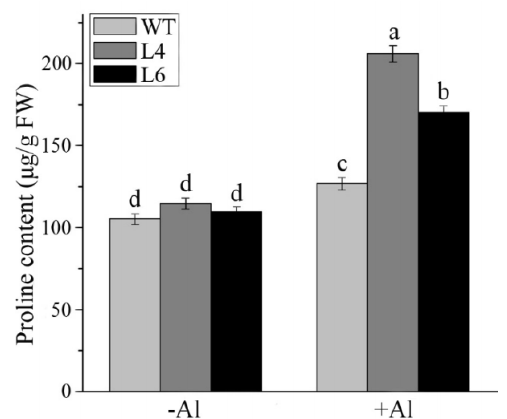
Figure 11. Determination of free proline in wild–type plants and transgenic lines. Two-week-old seedlings were treated with or without 60 µ M AlCl 3 for 12 h, and the proline contents of roots were determined after that. Values are means ± SD ( n = 20). Different letters indicate significant differences ( p < 0.05) (Tukey’s